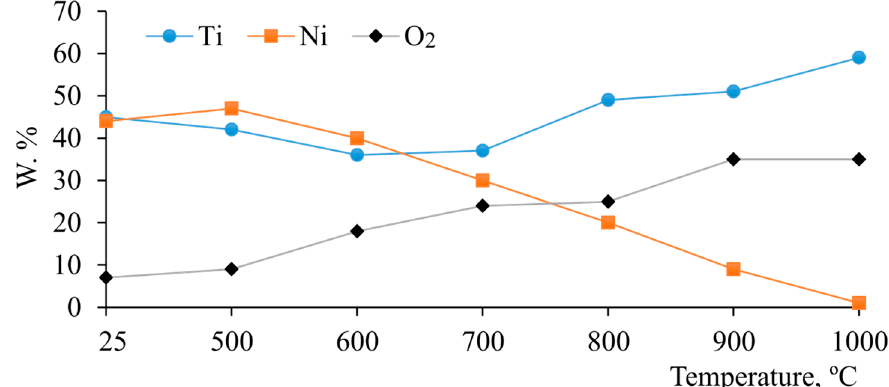
Figure 4. The elements weight fraction dependence on annealing temperatures.